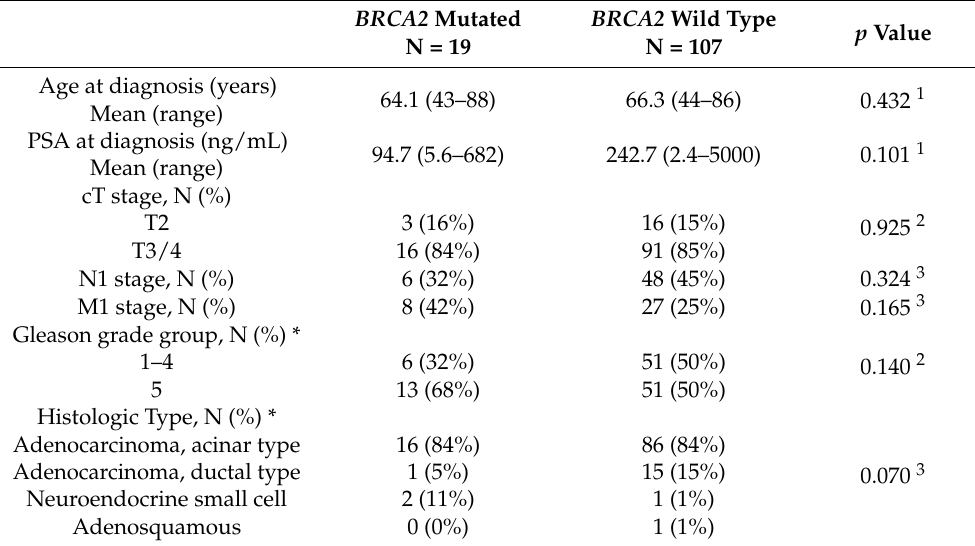
Table 1. Clinical and Pathologic Characteristics of BRCA2 mutated